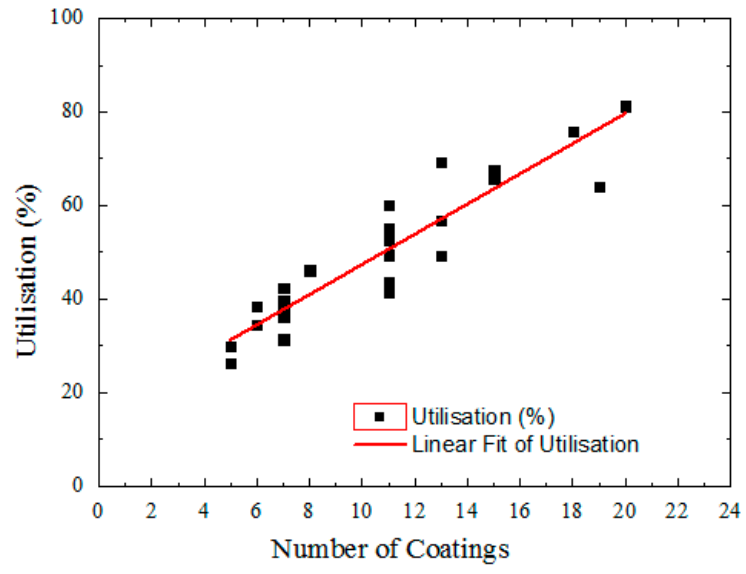
Figure 2. Amorphous fluoropolymer utilization depending on number of coatings printed.